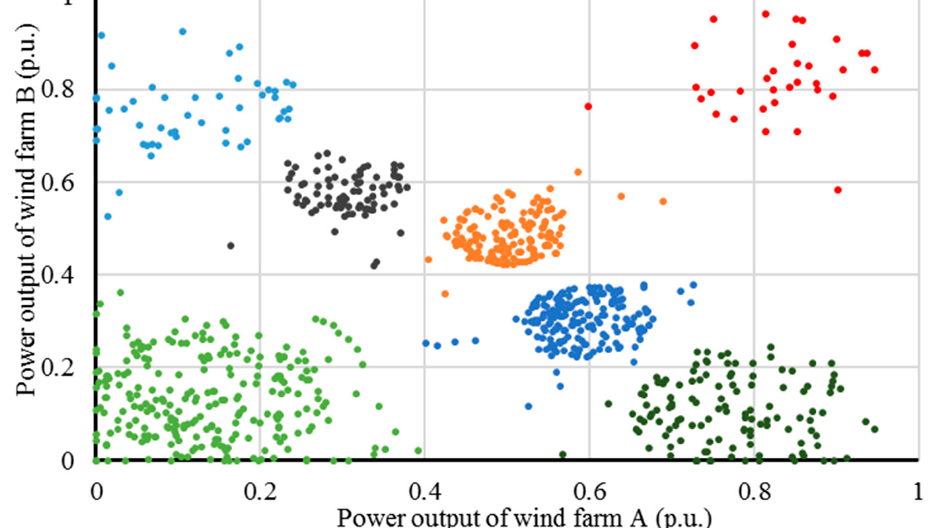
Figure 3. Clustering result of wind power dataset.